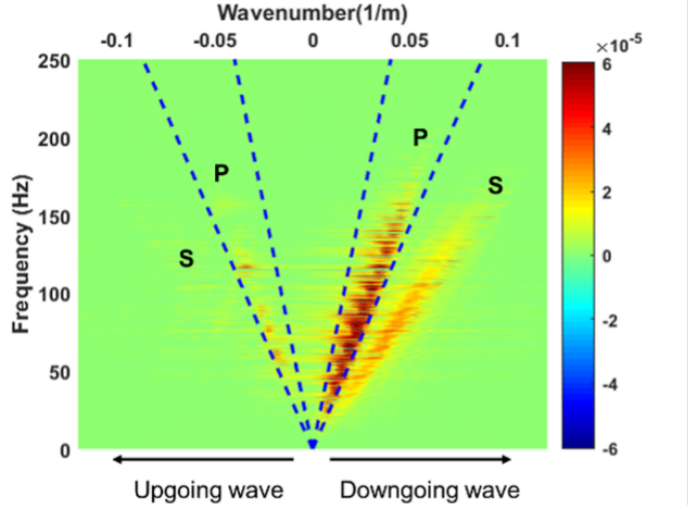
Figure 3. Up- and downgoing wavefield separation in the f - k domain using synthetic data. The area between the blue dashed line represents the P-wave energy that we pass. The slope of the dashed line is based on the chosen Vp